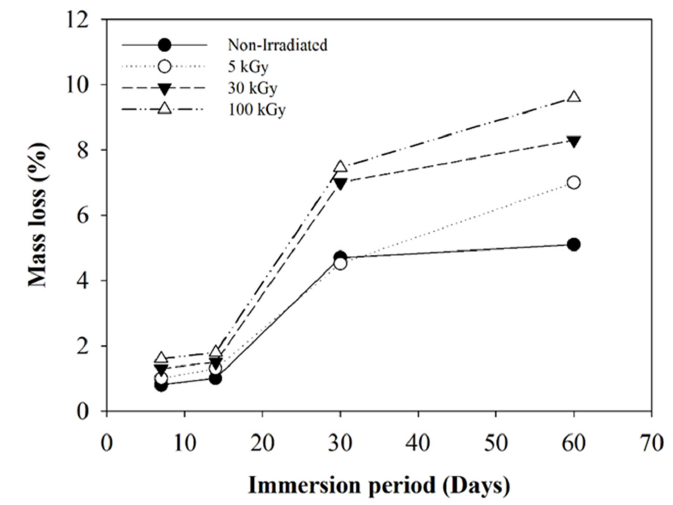
Figure 13. Mass loss of the PLLA/CMS/ β -TCP exposed under different irradiation doses of electron beam after 60 days immersion in PBS medium.